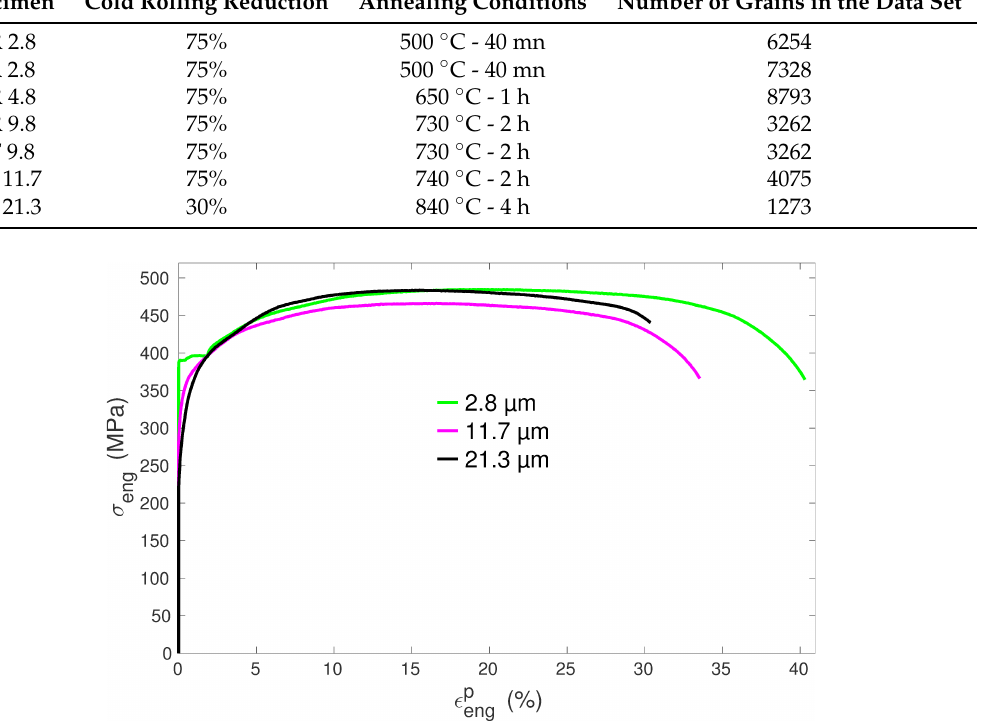
Figure 1. Engineering stress versus engineering plastic strain for three specimens of RR type with different mean grain